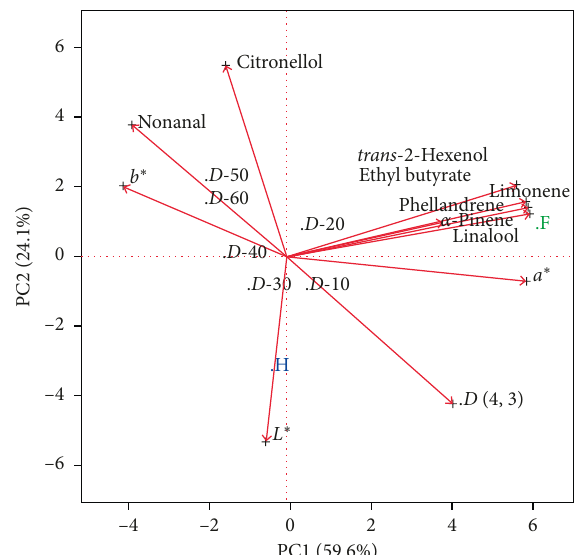
Figure 5: PCA plots comparing the DPCD-treated, fresh un- treated, and heat-treated orange juices. D -10, 20, 30, 40, 50, and 60 indicate DPCD durations of 10, 20, 30, 40, 50, and 60min, re- spectively, at 55 ° C and 40MPa. F: untreated freshly squeezed juice sample; H: heat-treated (90 ° C, 60 s) juice